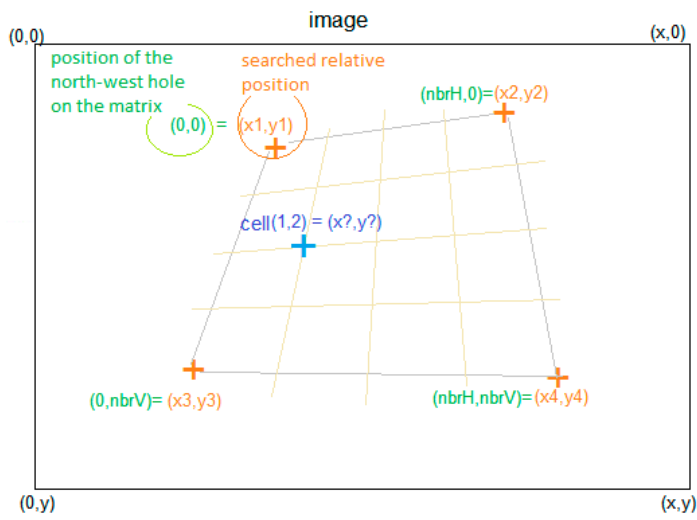
Figure 13. Detection of the positions of smartsurface holes on the captured image.